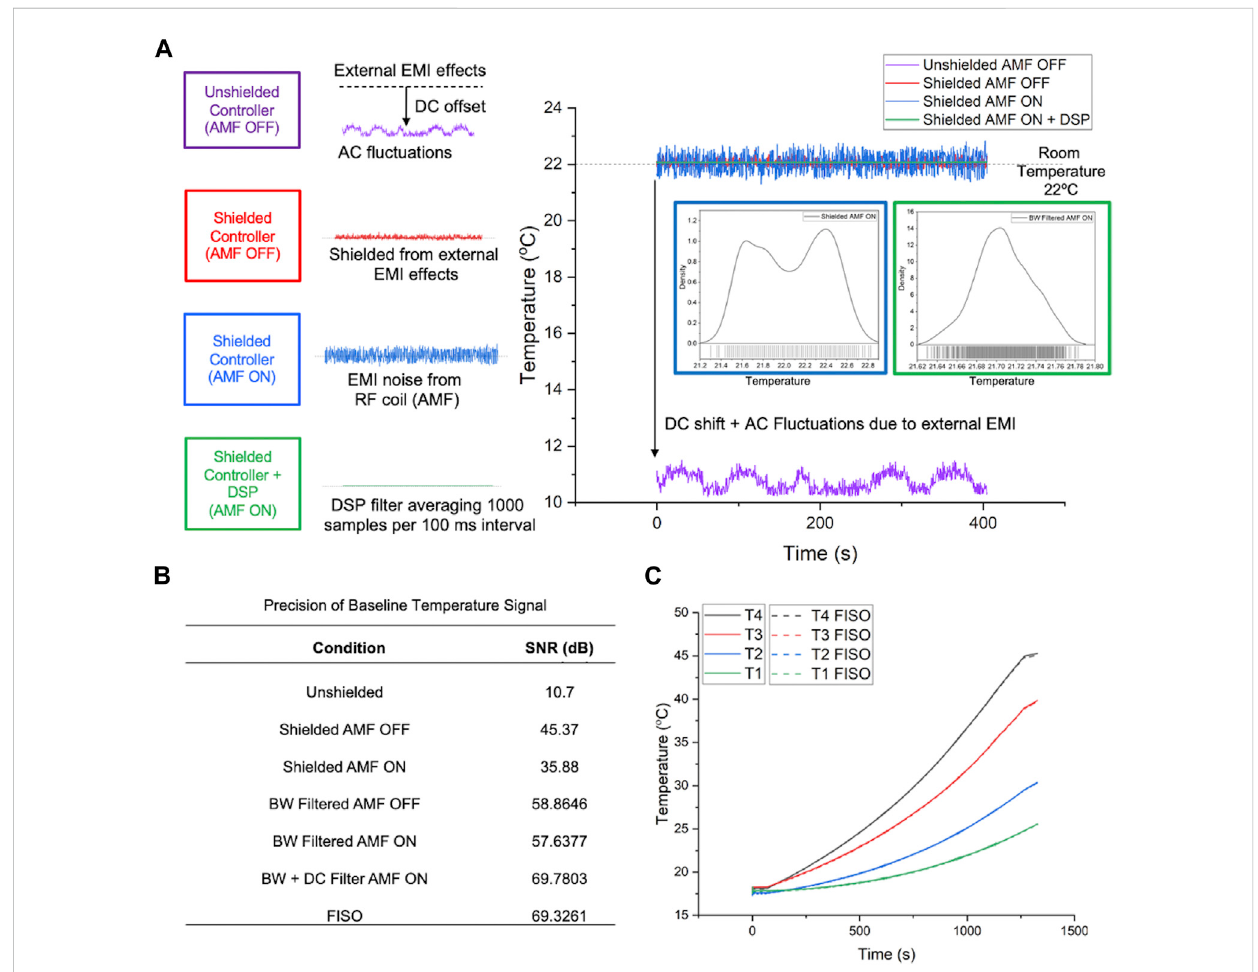
FIGURE 3 Improvementsinprecisionandaccuracyofthedigitizedprobetemperaturesignal. (A) ImprovementinsignalSNRthroughmechanicalshieldingand application of a digital low pass Butterworth (BW) fi lter. Inset fi gures in A and Table B show that the low pass fi ltering generates a Gaussian signal with an improved SNR. All connecting wires were shielded and shielding was electrically grounded to prevent offsets from ground loops. (B) Summarized signal precision, measured as SNR in dB, following each signal processing step for the digitized temperature signal vs. FISO reference signal. (C) Accuracy ofdigitizedtemperatureprobesignal inthe cRIOcontroller vs. calibrated temperaturesignal measuredby theFISO SPC-HR reading modules, for all four sensors on the FISO EVO probe, over the temperature range of 20 ° C – 45 ° C. Solid lines represent measurements taken from the cRIO controller and dashed lines show readouts from FISO SPC-HR reference reading